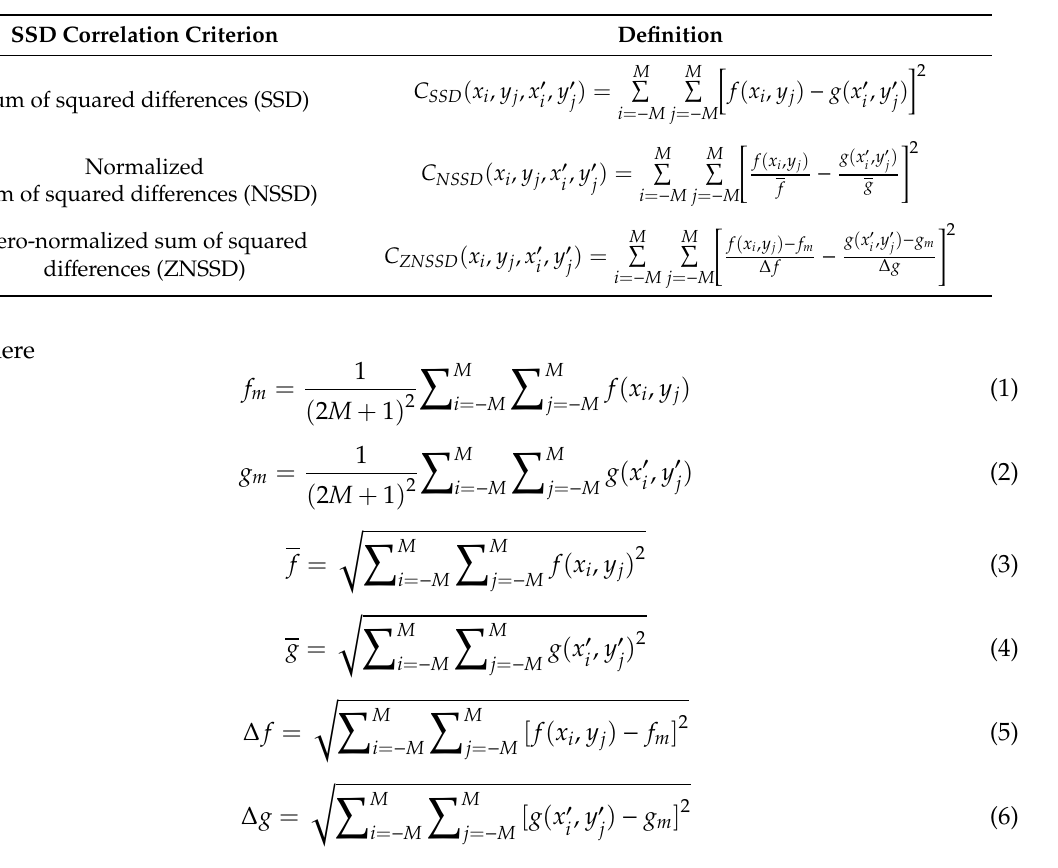
Table 2. Commonly used sum of squared di ff erences correlation (SSD) criteria and their